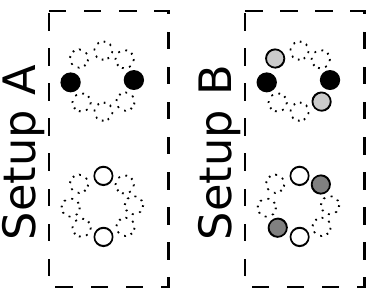
Figure 8. Microphone pairs setups used in the experiments (microphones with the same color belong to the same